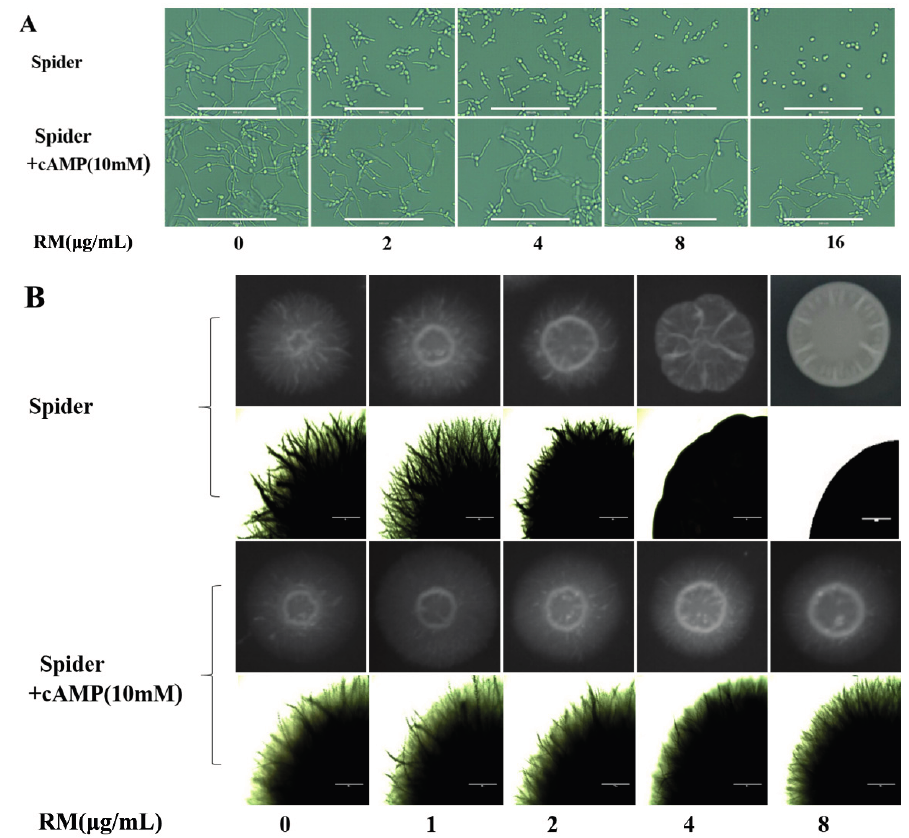
Figure 7. Addition of exogenous cAMP reverts the morphological transition defect of C. albicans SC5314 caused by RM. ( A ) Cells were incubated in liquid Spider medium supplemented with or without 10 mM cAMP. The cells were incubated at 37 °C for 4